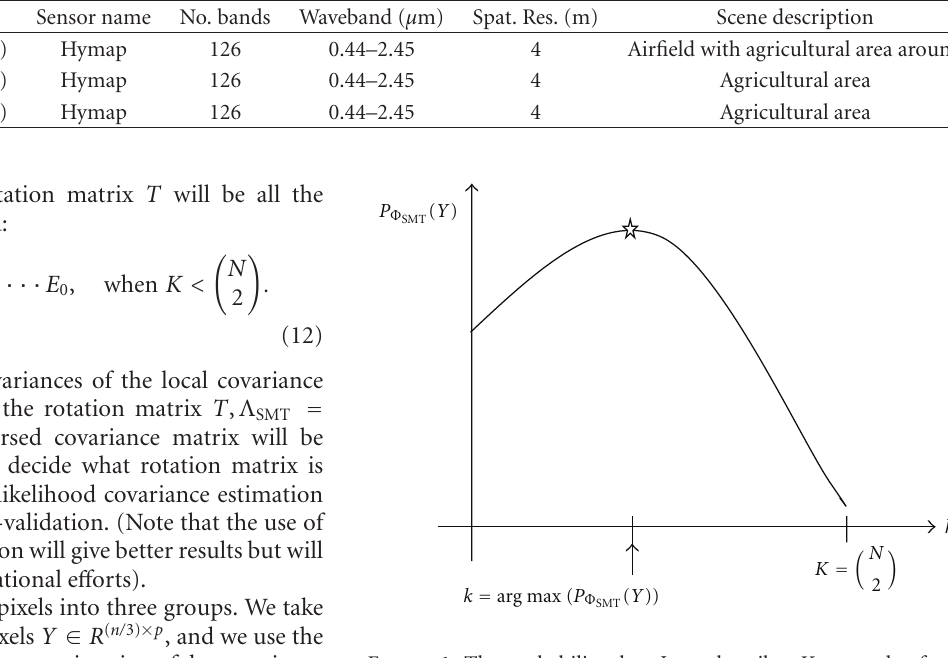
Figure 1: The probability that Φ SMT describes Y correctly after k rotations; the k that will be chosen is the one that gives the maxi- mum